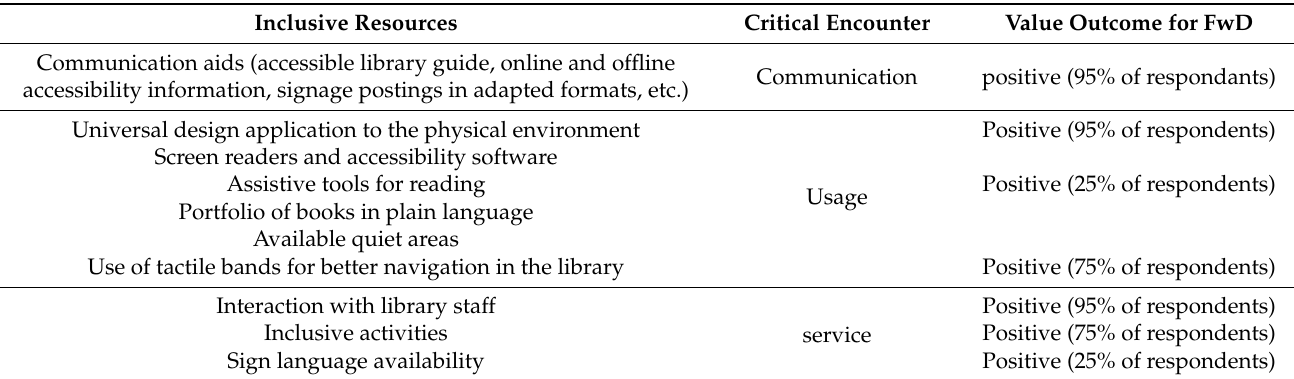
Table 4. Responses from the